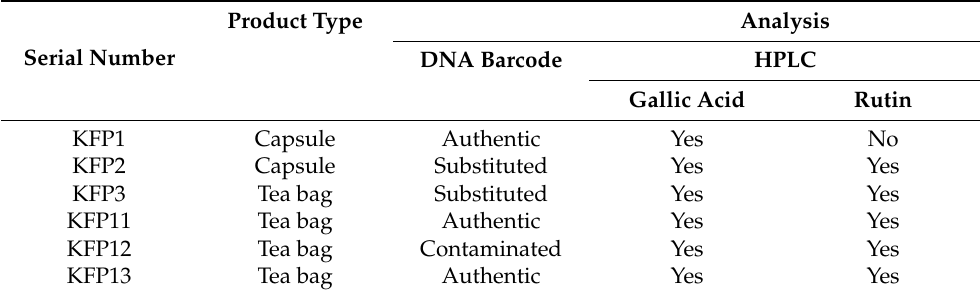
Table 3. Summary of L. pumila HMP authentication using DNA barcoding and